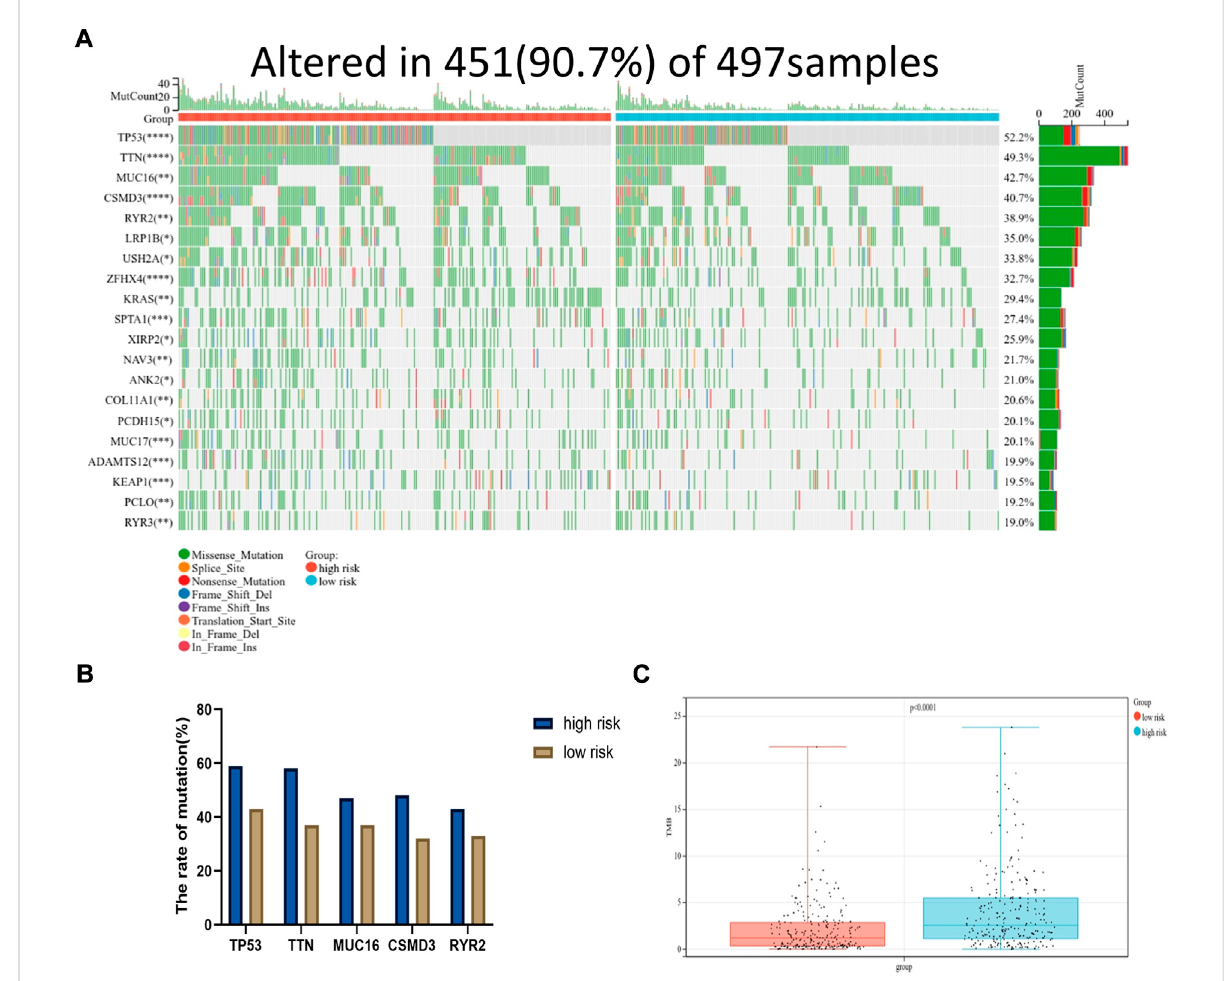
FIGURE 7 Mutationallandscapedisplayed via TCGA-LUAD database. (A) The waterfalldiagram exhibitedtop 20genes with highestmutationfrequency in LUAD between high and low risk group (* p < 0.05, ** p < 0.01, *** p < 0.001, **** p < 0.0001). (B) The mutation frequency of top fi ve genes. (C) The tumor mutation burden of high-risk group was signi fi cantly higher than that in low-risk group, p < 0.0001.